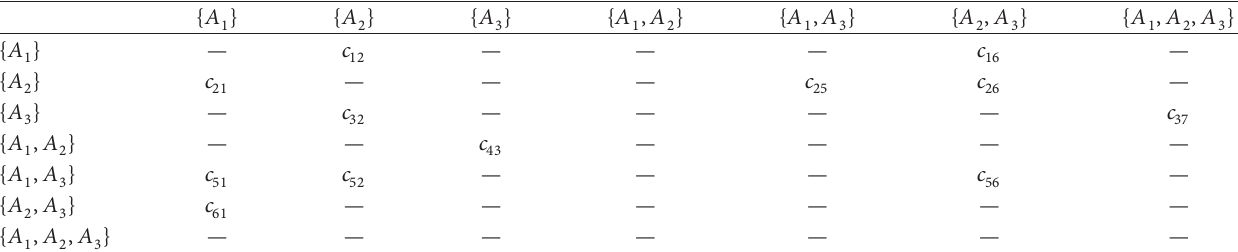
Table 2: The incomplete pairwise comparison matrix.